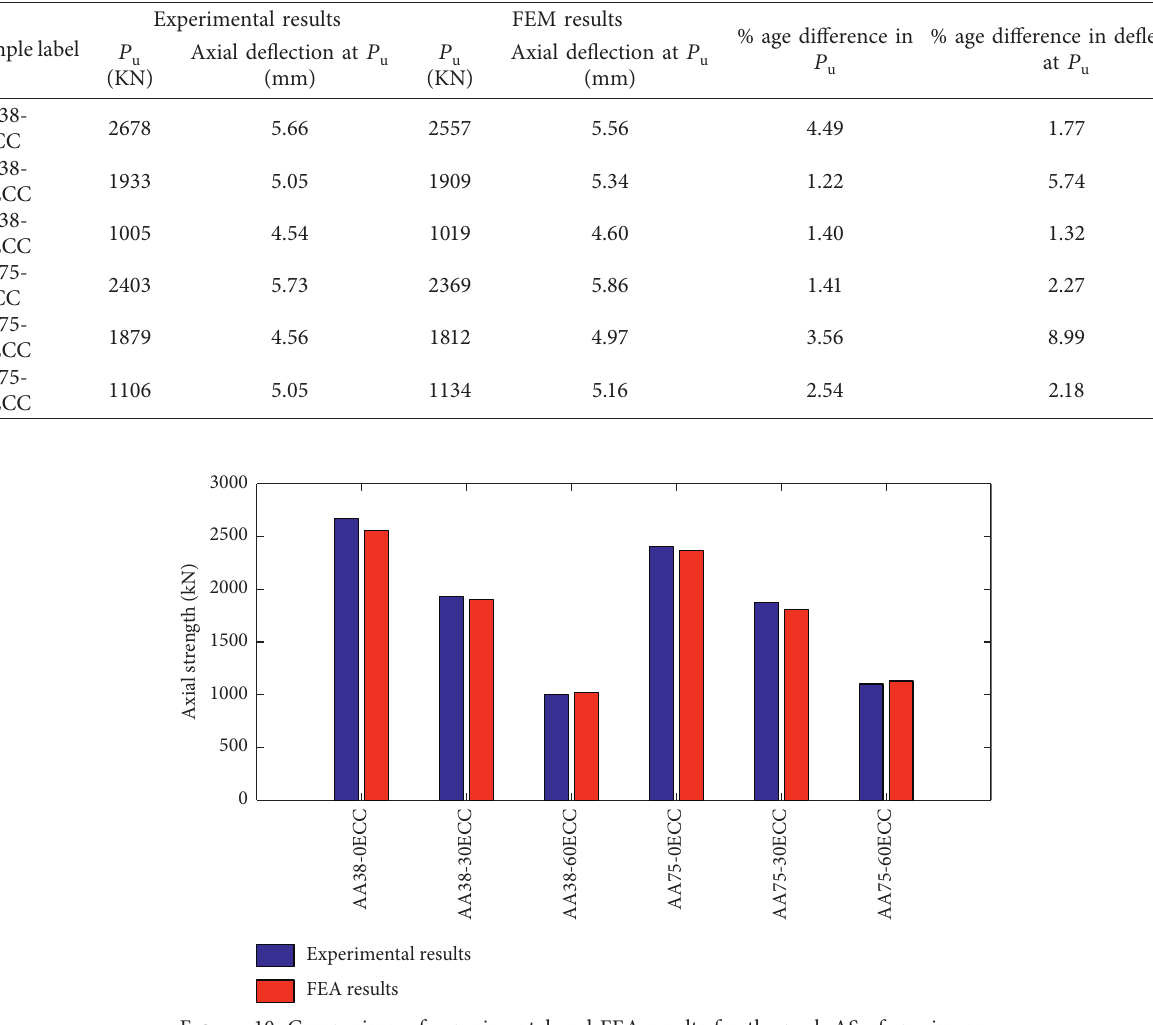
Table 4: Experimental and FEA results of axial peak load ( P